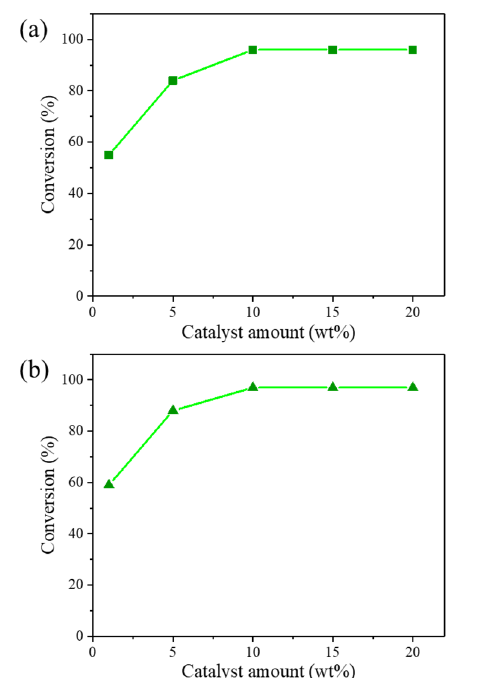
Figure 5. Effect of catalyst amount of ( a ) Zr(SO 4 ) 2 /SiO 2 and ( b ) Zr(SO 4 ) 2 /AC catalysts on the conversion of malic acid. Reaction conditions: Methanol amount (5 mL), malic acid amount (1 g), reaction time (2 h), reflux temperature, stirring speed (600 rpm).